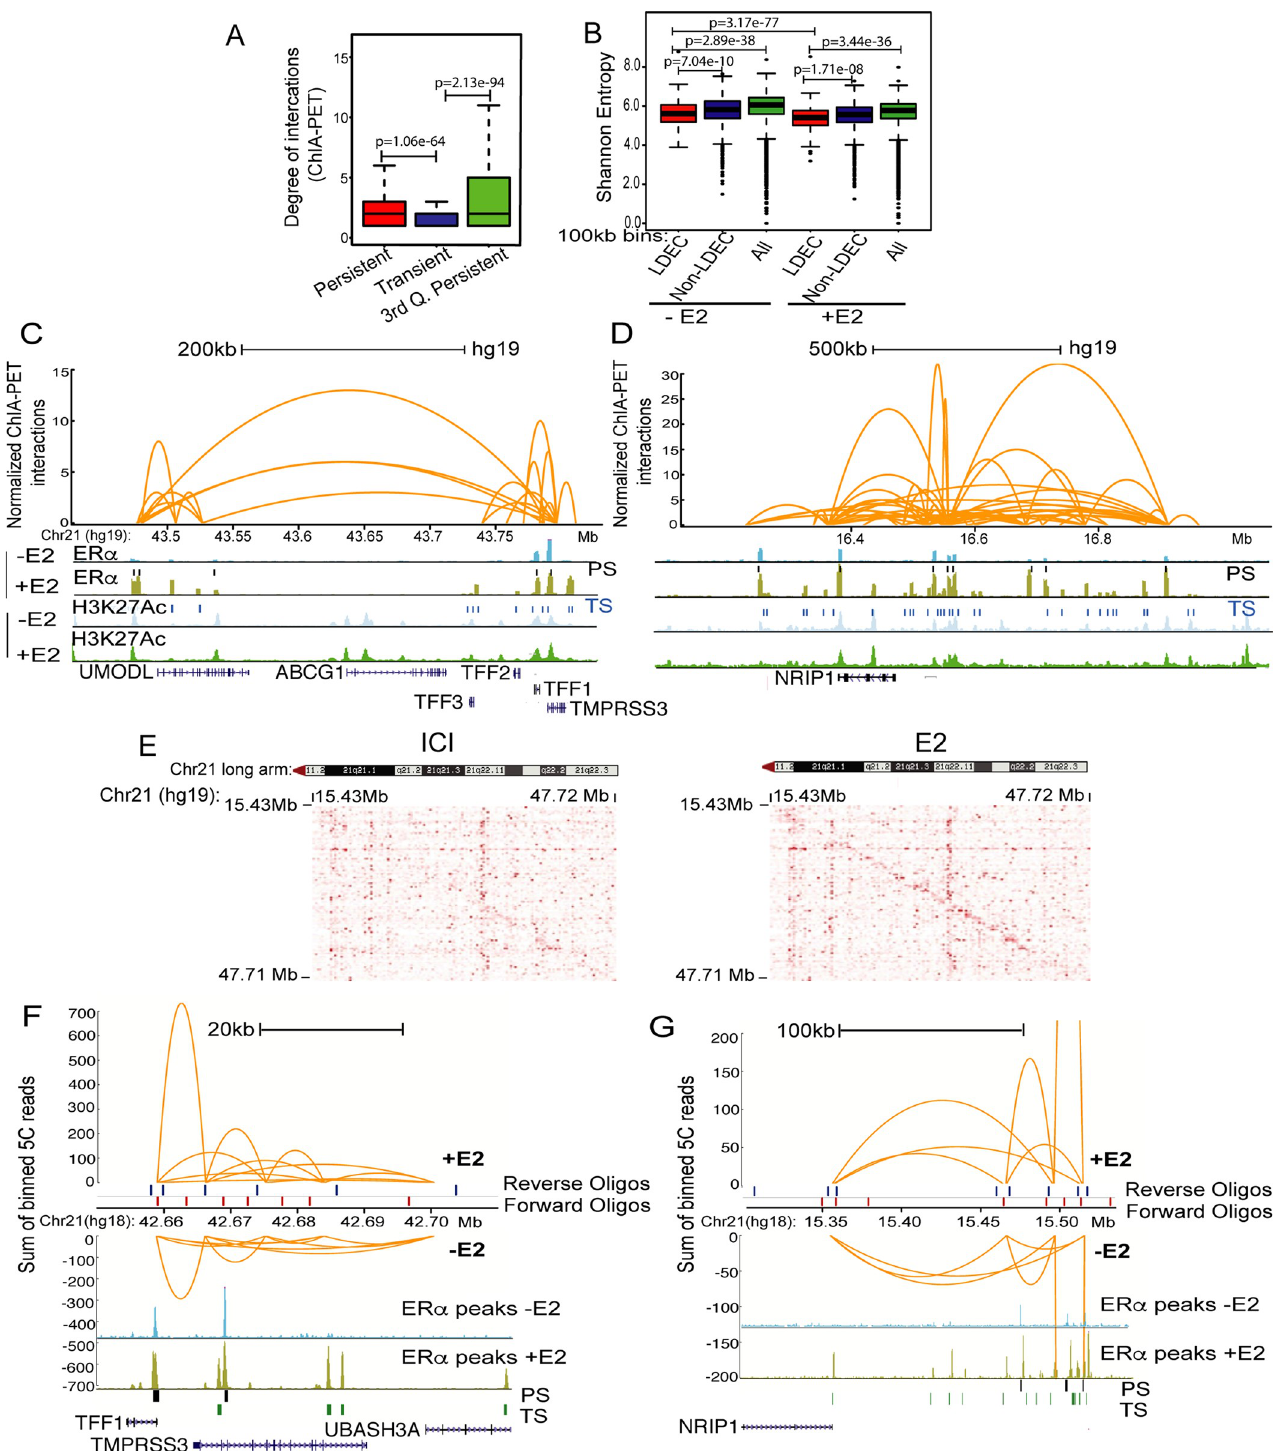
Fig 3. Genomically clustered ER α sites exhibit 3D proximity with each other and with target gene promoter(s). (A) Distributions of the degree of interactions emanating from the persistent, transient and 3 rd quantile persistent sites, derived from ER α ChIA-PET data. (B) Shannon entropy plots taking 100kb genomic bins showing the drop of entropy upon E2 stimulation. The bins with LDEC exhibit highest drop compared to Non-LDEC and all bins. (C) ER α ChIA-PET data plotted for TFF1 and (D) NRIP1 LDEC. Orange arches depict the interaction pairs derived from one replicate, height of loops represent the strength of interaction. The panels are overlaid on ER α and H3K27ac ChIP-seq tracks in plus and minus E2 conditions from MCF-7 cells. (E) 5C matrix from